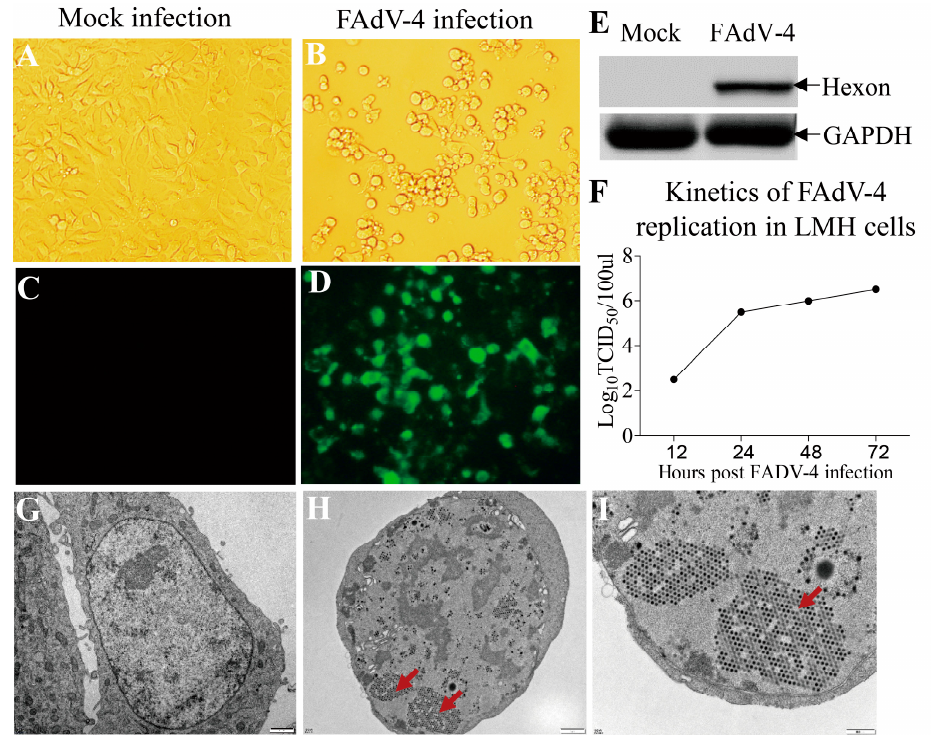
Figure 1. Replication of FAdV-4 strain HuBWH in LMH cells. ( A – D ) LMH cells were mock infected (A and C) or infected with FAdV-4 at an MOI of 1 ( B , D ). Twenty-four hours after FAdV-4 infection, cells were subjected to IFA staining using mouse anti-hexon polyclonal antibodies followed by FITC-conjugated goat anti-mouse IgG antibodies and were visualized under a fluorescence microscope. Magnification, × 400. ( E ) Detection of the viral protein hexon in FAdV-4-infected or mock-infected LMH cells by Western Blot using an anti-hexon McAb. ( F ) Examination of FAdV-4 replication in LMH cells. LMH cells were infected with FAdV-4 at an MOI of 1. At different time points (12, 24, 48, and 72 h) after FAdV-4 infection, the viral titers in the cell cultures were determined by TCID 50 . (G to I) Examination of FAdV-4 HuBWH particles by TEM. LMH cells were mock infected ( G ) or infected with FAdV-4 at an MOI of 1 for 24 h ( H ). A higher-magnification view of panel H is demonstrated by ( I ) (The FAdV-4 particles are indicated by red arrows). Scale bar = 1 µ m in G&H; Scale bar = 500 nm in